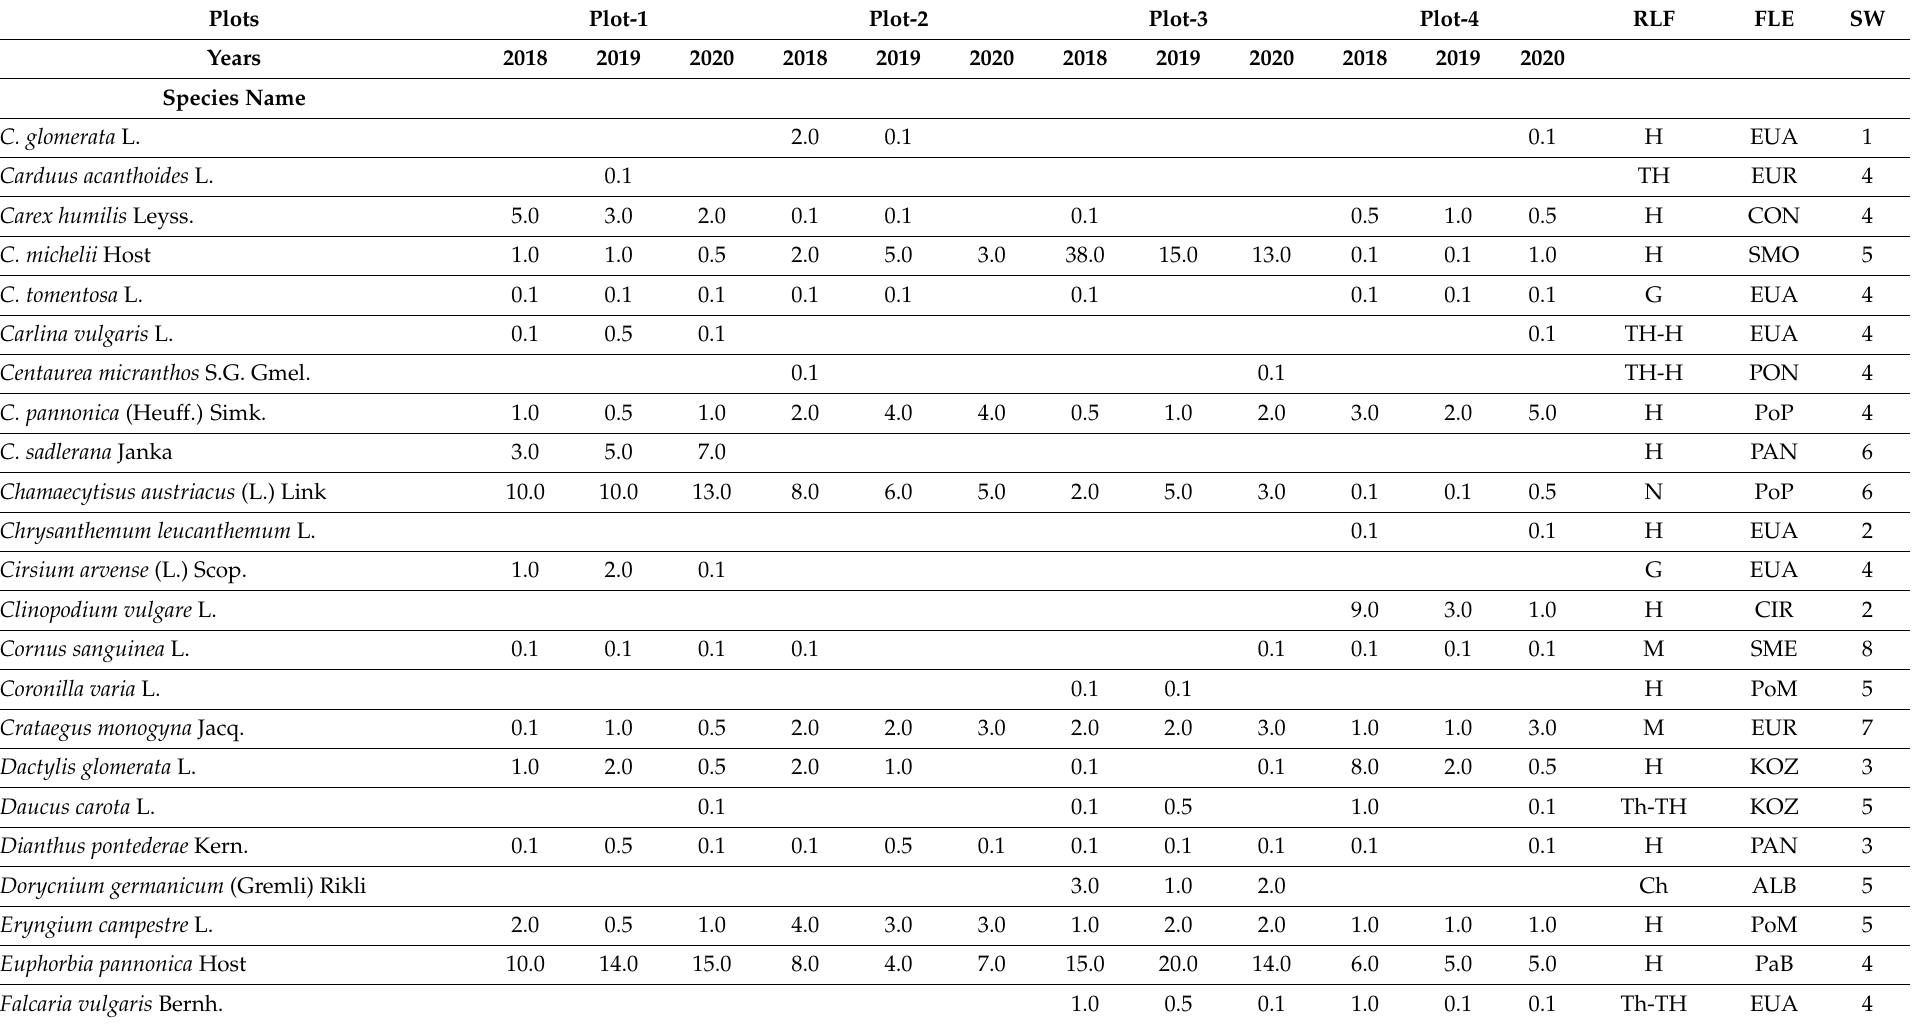
Table A1. Cont. Plots Plot-1 Plot-2 Plot-3 Plot-4 RLF FLE SW